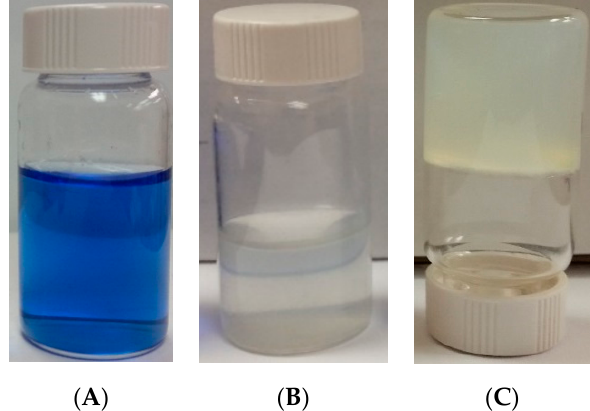
Figure 7. Sample AB45 dye solution ( A ), treated solution ( B ) and jellified solution ( C ).